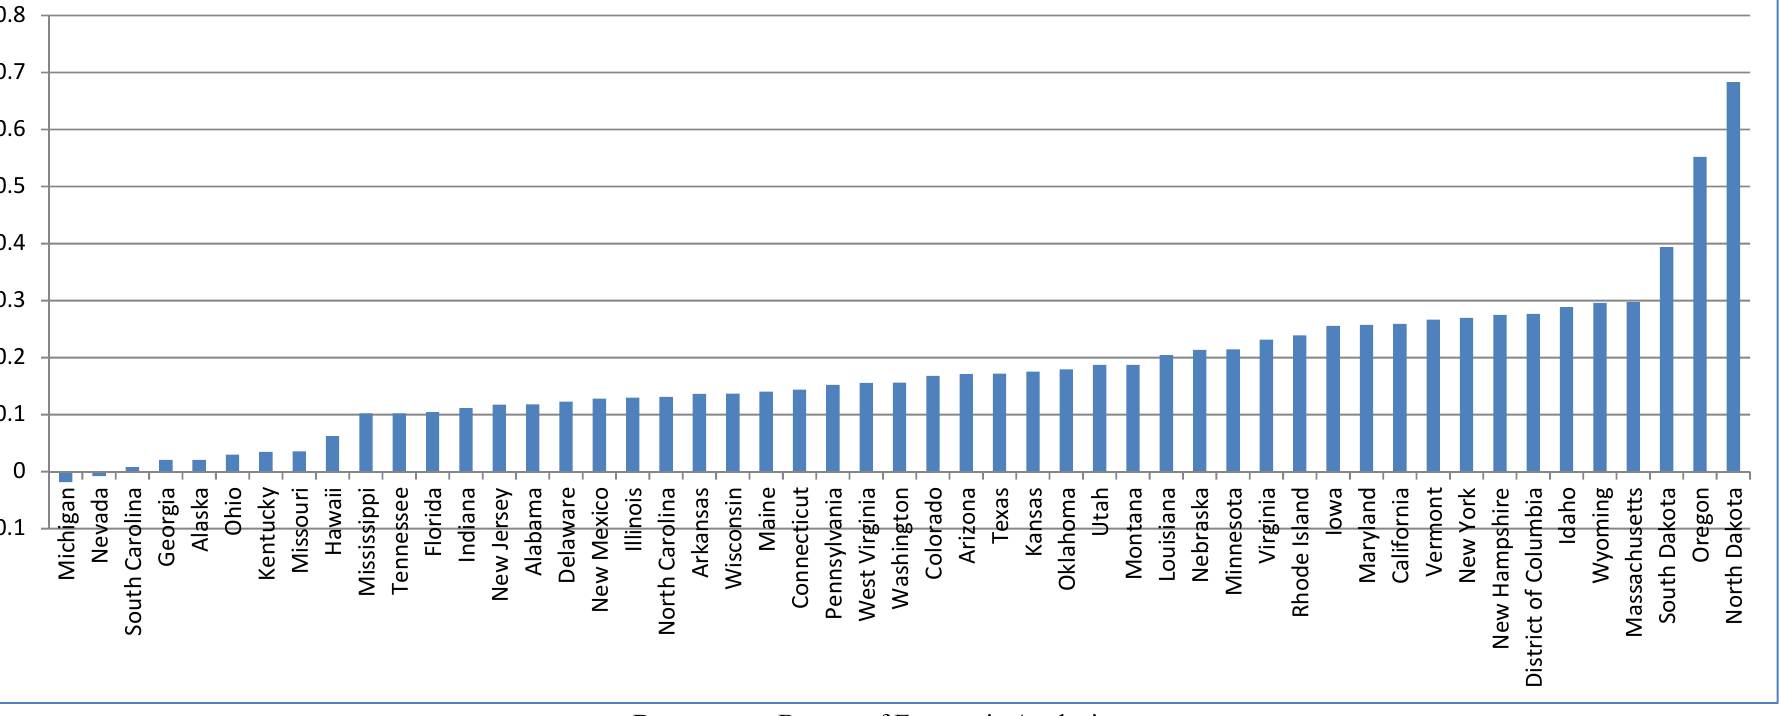
Date source: Bureau of Economic